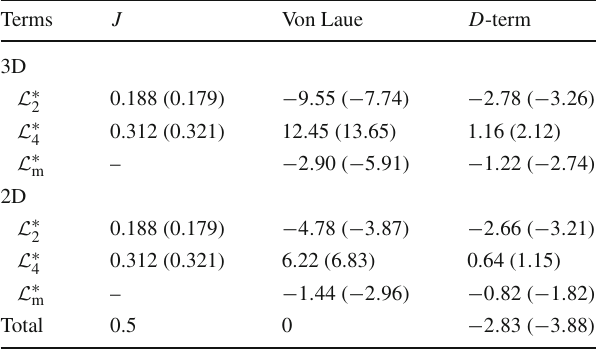
Table 2 Contributions of the different terms to the angular momentum J , the stability condition (Von Laue condition), and the values of the D -term extracted from the pressure distributions for ρ = 0 ( ρ = ρ 0